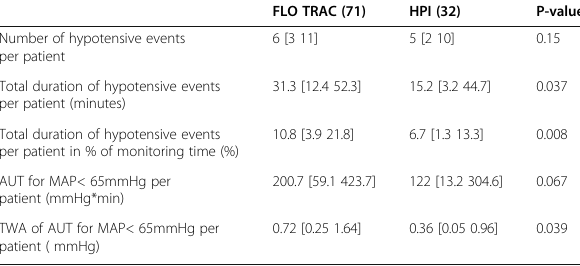
Table 1 (abstract A19). Characteristics of